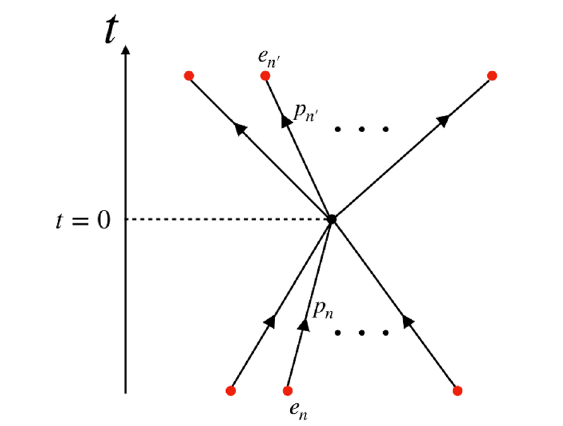
Figure 1 . The trajectories of charged particles corresponding to